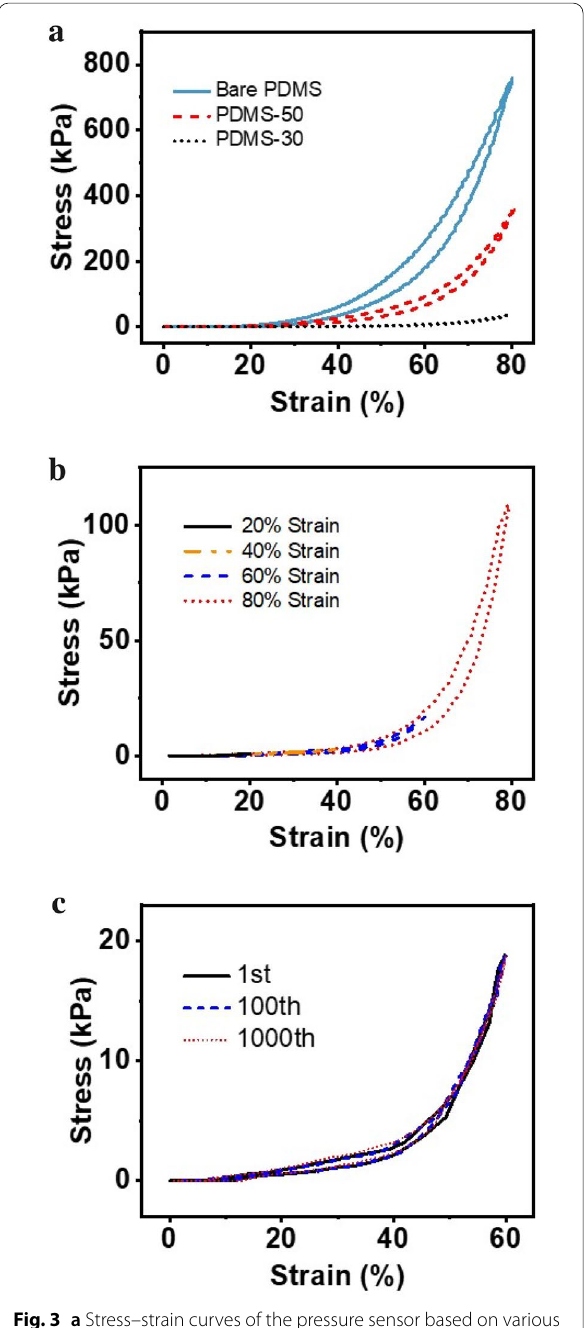
Fig. 3 a Stress–strain curves of the pressure sensor based on various weight concentrations of bare PDMS (blue solid line), in this case 50 wt% (red dash line) and 30 wt% (black dot line) at 80% compressive strain. b Sequential loading–unloading cycles of PDMS-30 foam under compressive strain ranging from 20 to 80%. c Cyclic compression tests of the PDMS-30 foam sample at 60% compressive